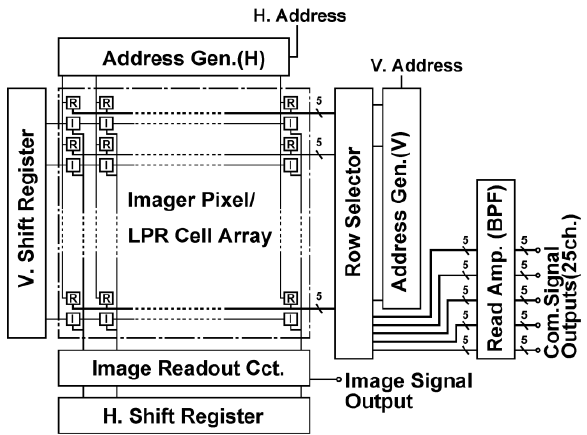
Figure 2. Architecture of the CMOS ISC chip (R: LPR cell, I: Image